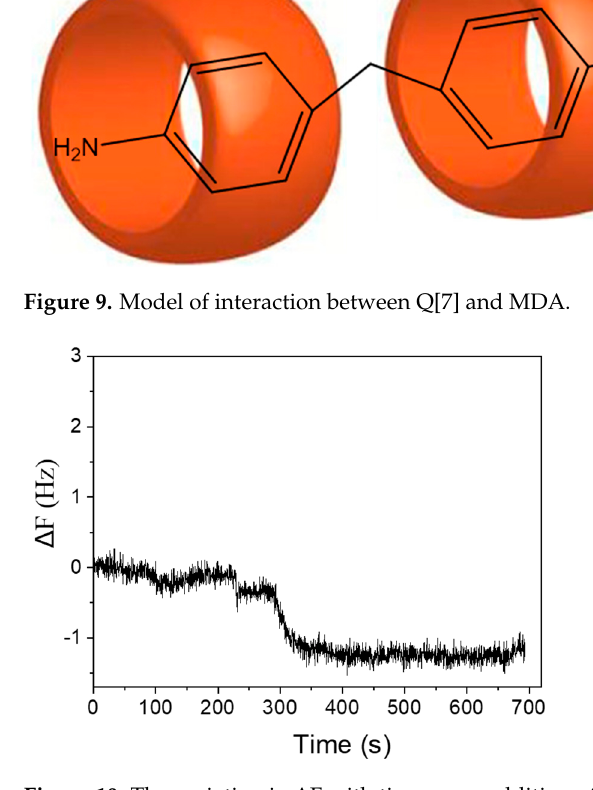
Figure 10. The variation in Δ F with time upon addition of Q[7] (0.1 mmol·L − 1 ).